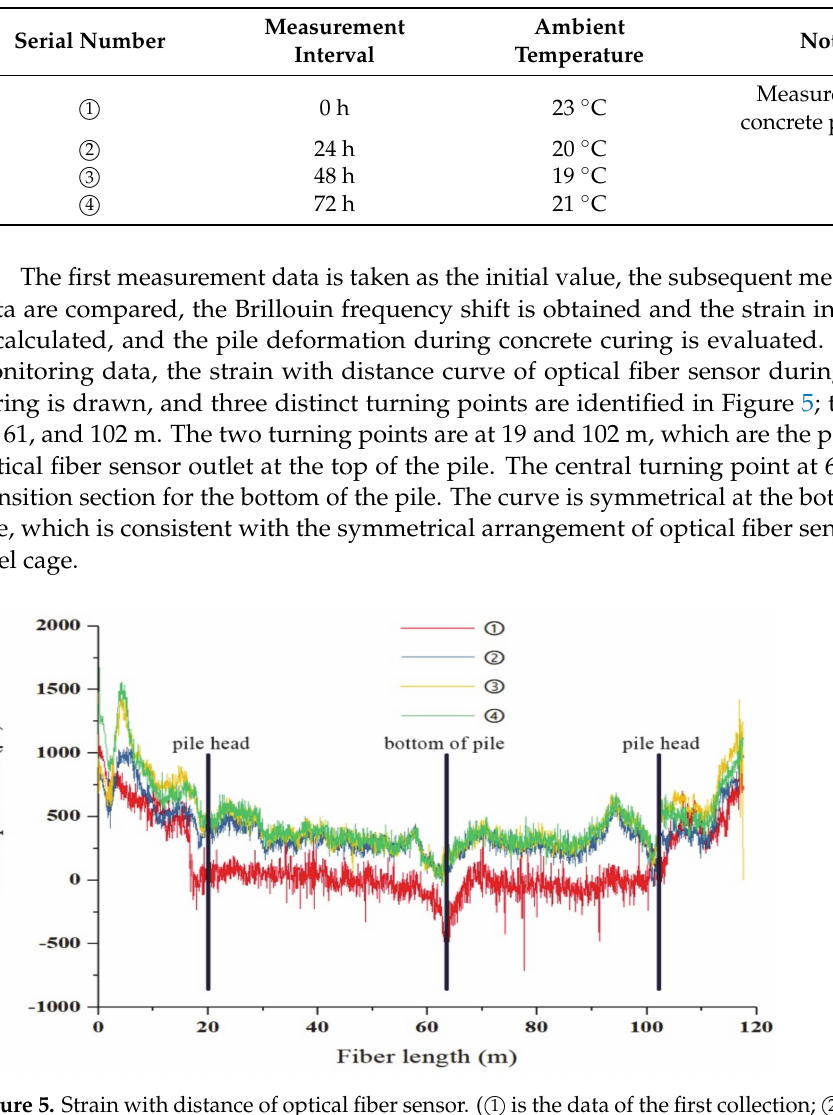
Figure 5. Strain with distance of optical fiber sensor. ( 1 (cid:13) is the data of the first collection; 2 (cid:13) is the data of the second collection; 3 (cid:13) is the data of the third collection; 4 (cid:13) is the data of the fourth